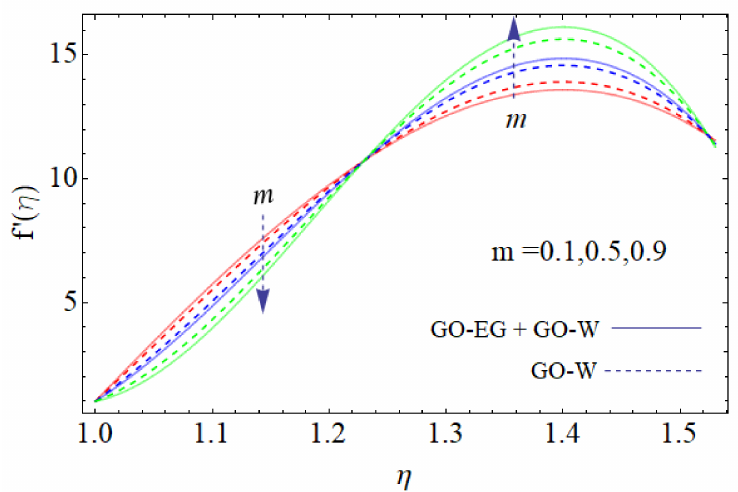
Figure 7. Influence of the magnetic field parameter on the velocity profile.